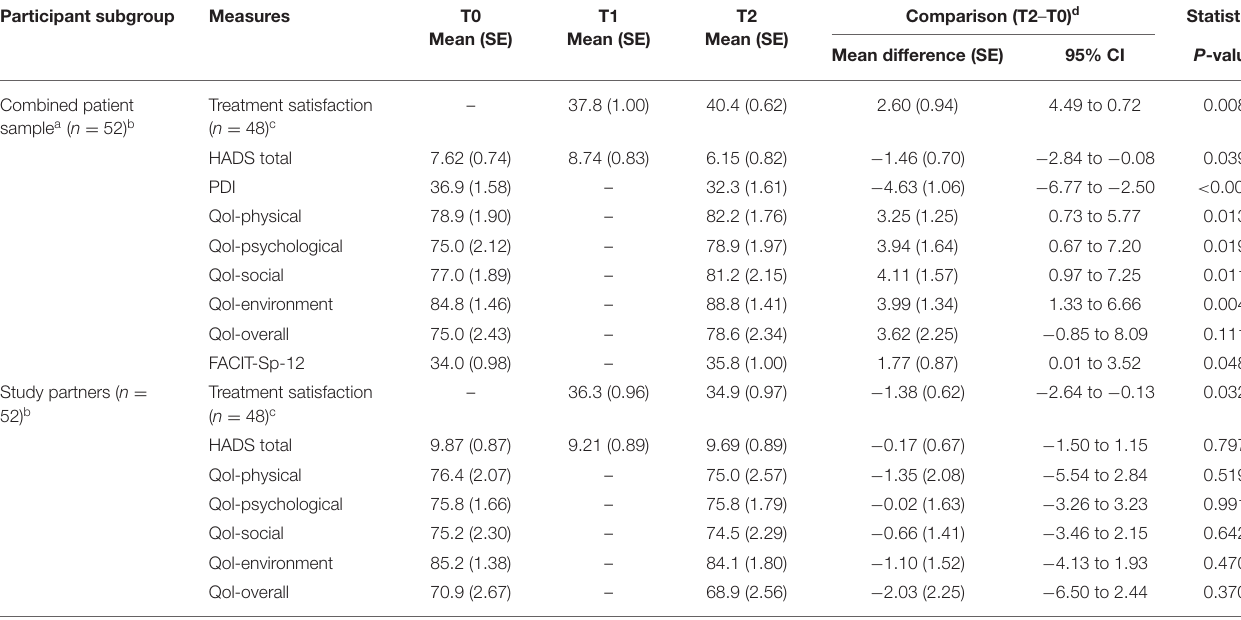
TABLE 3 | Treatment satisfaction and secondary outcomes in the whole sample of patients complemented by a comparison in study partners. Participant